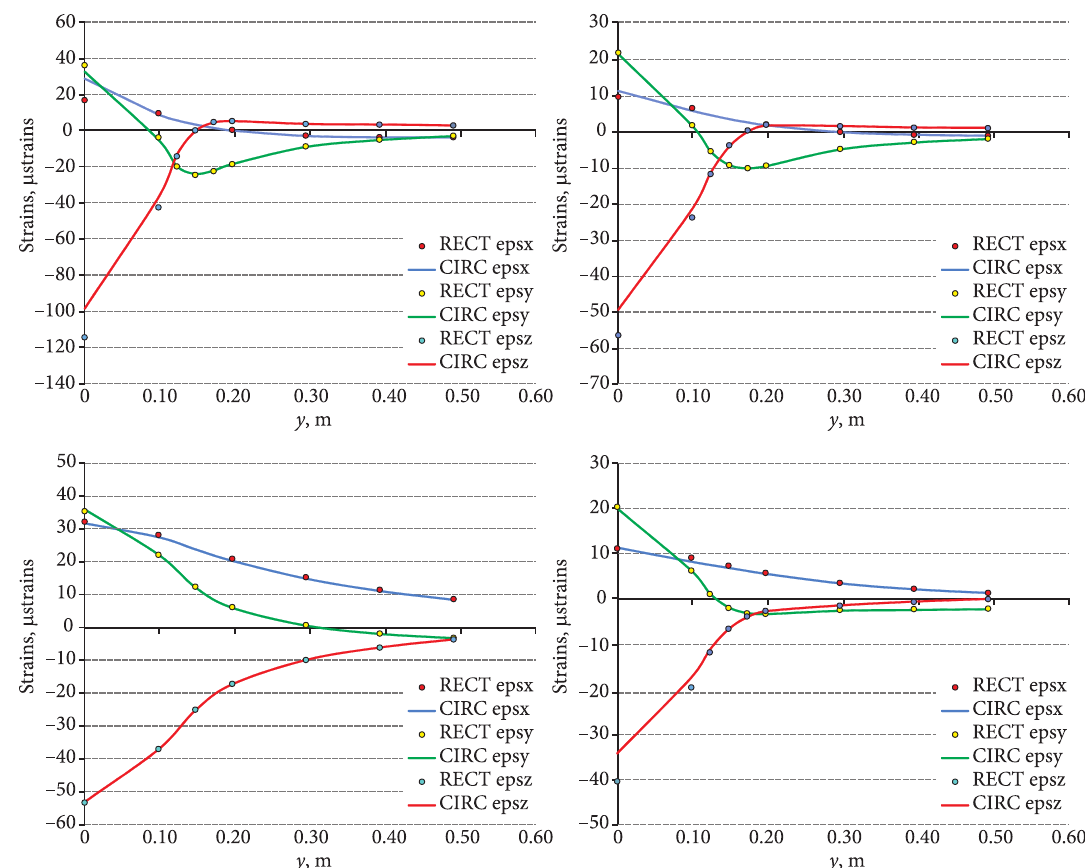
Fig. 4. Examples of the comparison between strains obtained with the circular footprint configurations chosen and strains calculated with the rectangular